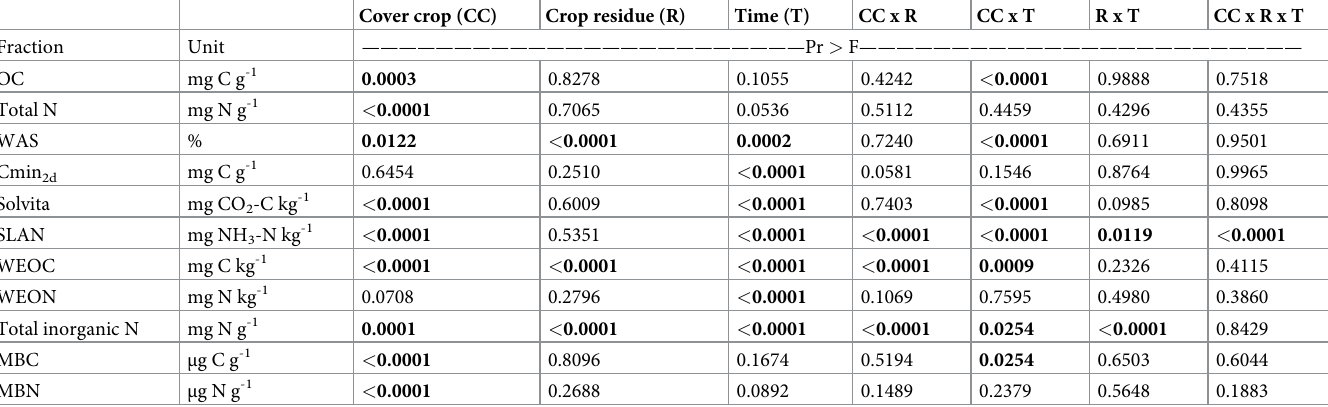
Table 4. Probability values for the main effects of medium-term summer-planted cover crop (6-yrs), crop residue management, sampling time, and interactions on soil stable and labile fractions of C and N sampled from 0–15 cm depth in site-year